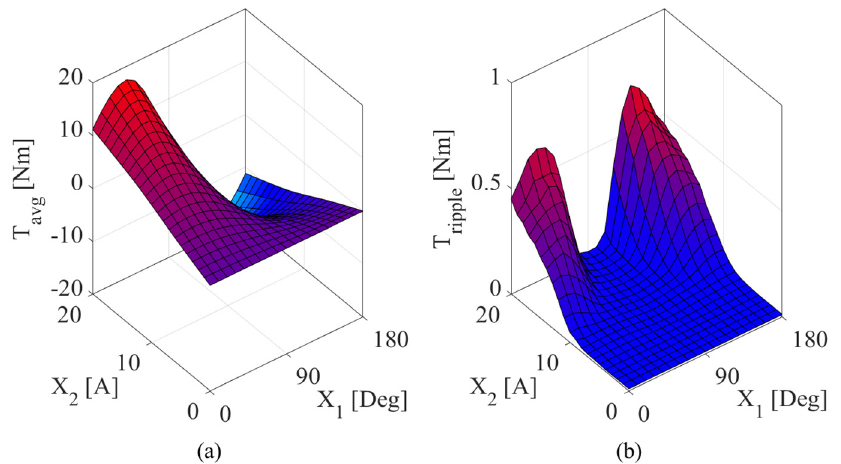
Figure 14. FEA results for torque performance of the Model-V: ( a ) Average Torque, and ( b ) Torque Ripple.